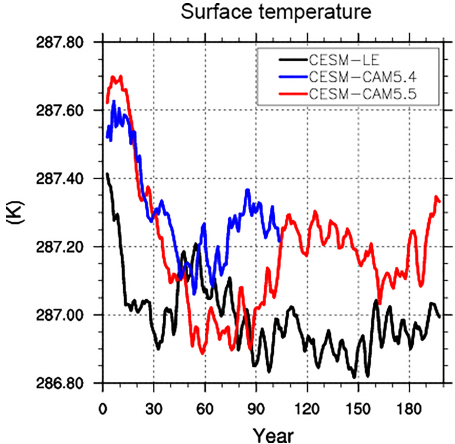
Figure 1. Evolution of the globally averaged surface temperature for the first 200 years of the pre-industrial control run for CESM- CAM5.3 (black curve, CESM large ensemble), CESM-CAM5.4 (blue curve), and CESM-CAM5.5 (red curve). CESM-CAM5.4 was only run for 106